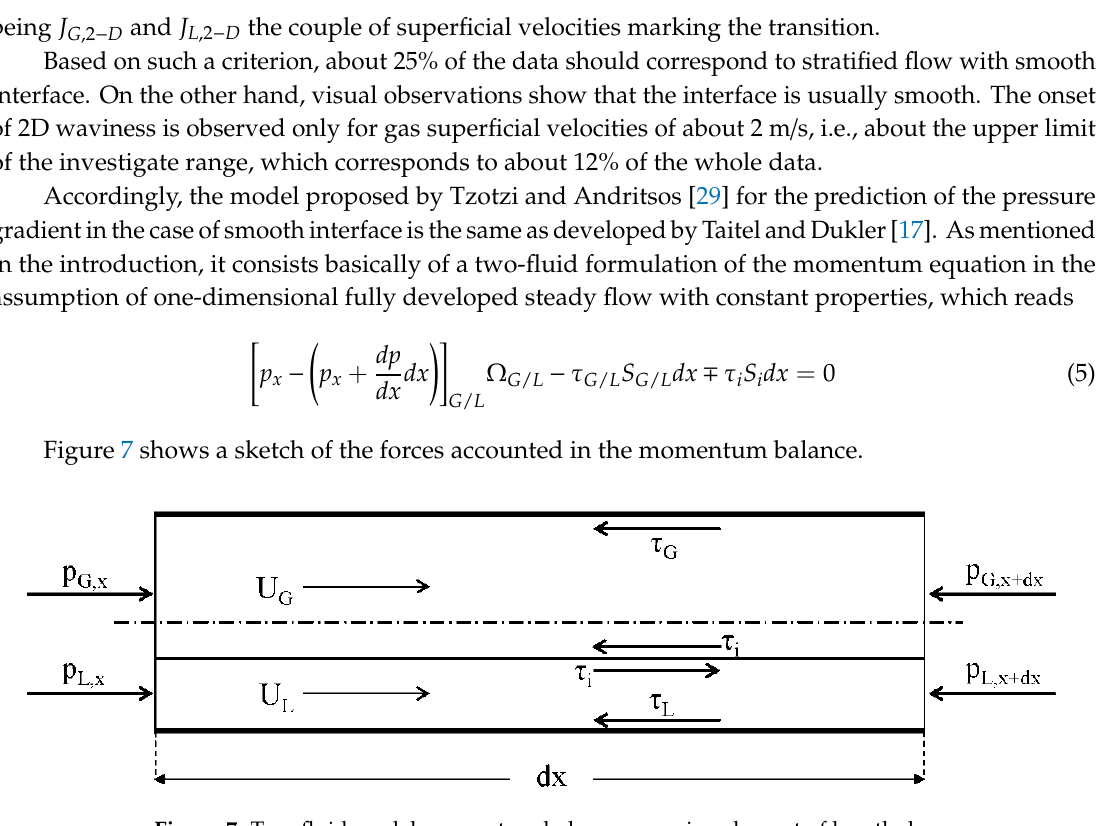
Figure 8. MAPE vs. superficial gas velocities at different superficial liquid velocities. Accordingly, void fraction measurements were also taken in order to solve the two-fluid model, Equations (6) and (7), for the interfacial shear stress and hence provide an empirical correlation to be adopted in the considered range of the gas superficial velocities. 3.2. Void Fraction Since both Taitel and Dukler [17] and Ullmann and Brauner [30] models return unsatisfactory predictions for the void fraction, especially at low air-flow rate, three correlations available in the open literature were implemented (see Table 6), i.e., Armand [37], being one of the simplest general correlations implemented for two-phase flow, Guzhov [38], as it was developed specifically for plug 0% 50% 100% 150% 200%